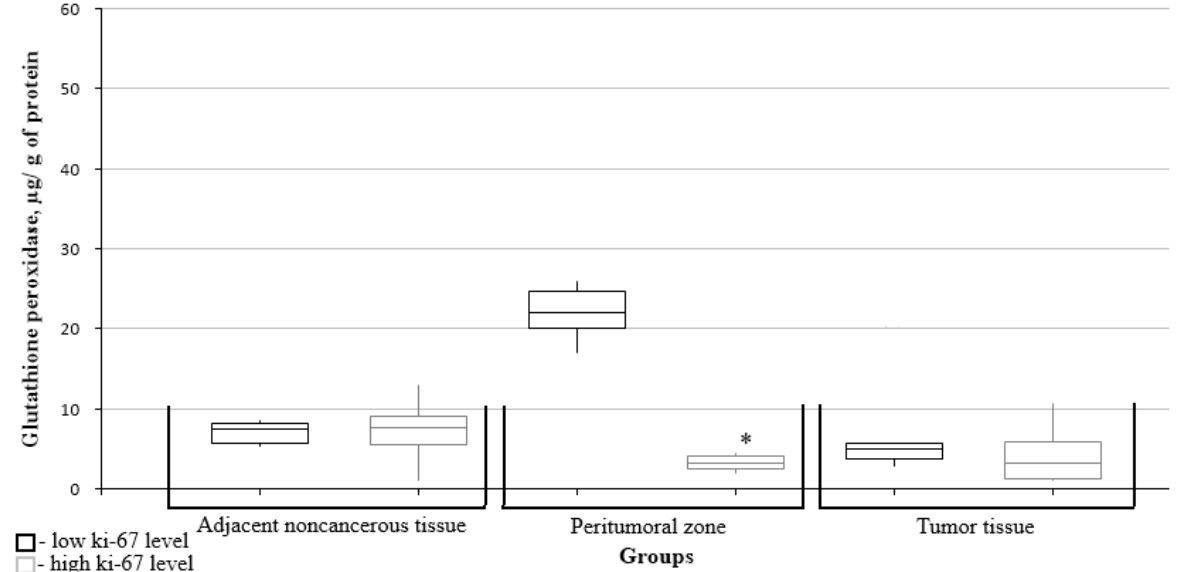
Figure 5. Medians and interquartile ranges (IQRs) of glutathione peroxidase levels in gliomas as a function of the Ki-67 mitotic index value. There are significant differences between the glutathione peroxidase levels in peritumoral zone tissues (*—Mann-Whitney U-test p = 0.004) and the low and high mitotic index Ki-67 groups.